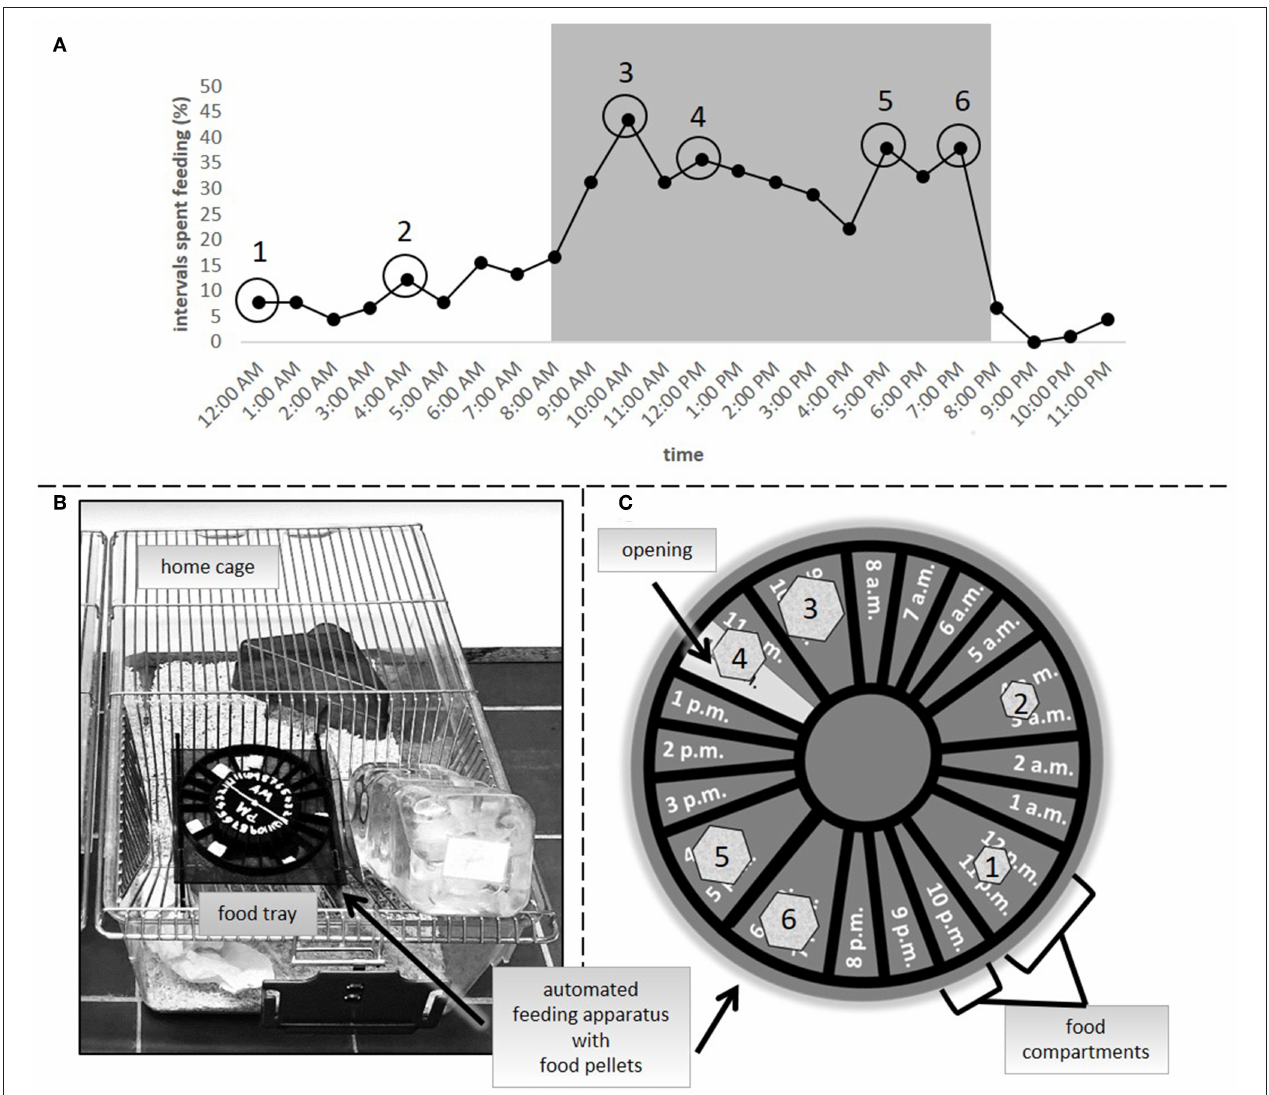
FIGURE 2 | (A) Feeding activity as percentage of intervals spent feeding in ad libitum fed mice ( n = 15). Numbers 1–6 symbolize the feeding time points in the AUTO group. (B) Clock-like apparatus positioned in the food tray of a home cage. (C) Symbolic representation of the automated feeding apparatus. Food pellets were divided into smaller pieces, reflecting differences in the feeding activity at the different time points [1–6, as indicated in (A) ] and placed into the respective food